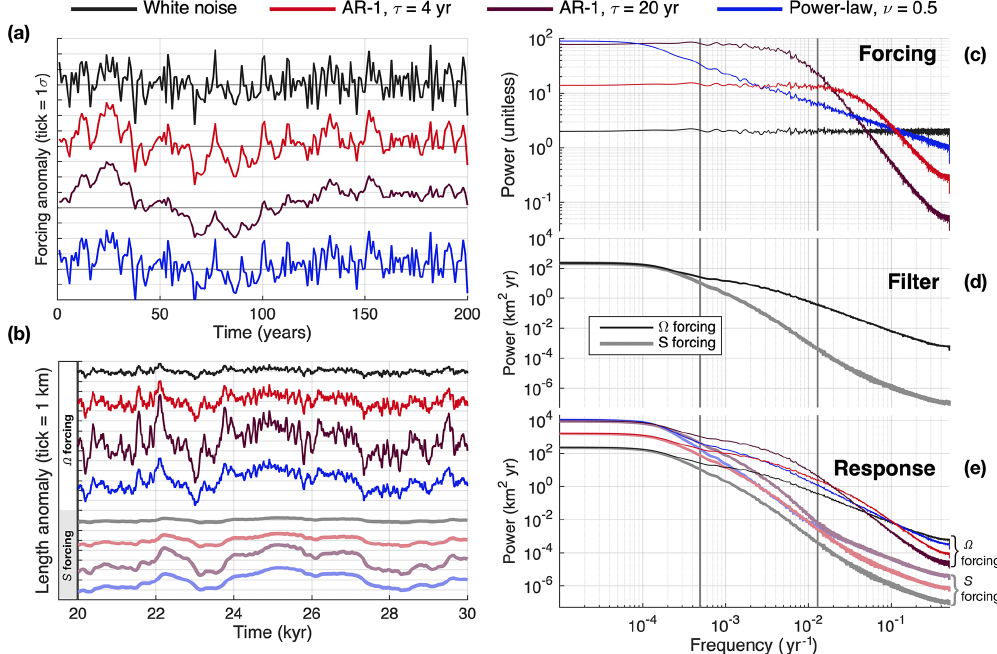
Figure 4. The effect of climatic persistence on glacier fluctuations. (a) Segments of synthetic anomalies with different levels of persistence: white noise (no persistence; black), red noise with τ AR1 = 4yr (red) and τ AR1 = 20yr (maroon), and power-law noise with ν = 0 . 5 (blue). Time series shown are dimensionless and offset for clarity, with vertical ticks of 1 σ . (b) The glacier-length variations generated by the two-stage model, when the synthetic anomalies are applied as (cid:127) (cid:48) (dark lines) and S (cid:48) (pastel lines). Time series are again offset, with vertical ticks of 1km. (c) Power spectra of the synthetic climate forcings. For reference, vertical lines correspond to 1 the glacier’s response to white noise, which illustrates the glacier’s sensitivity as a function of frequency and thus its temporal filtering properties. This depends on whether forcing is applied as (cid:127) (cid:48) (black) or S (cid:48) (gray). (e) Spectra of glacier response to (cid:127) (cid:48) (dark lines) or S (cid:48) (pastel lines). Responses depend on the spectra of the forcing and the glacier’s filtering properties. Forcing with persistence has more power at low frequencies where glacier sensitivity is highest, increasing the overall glacier